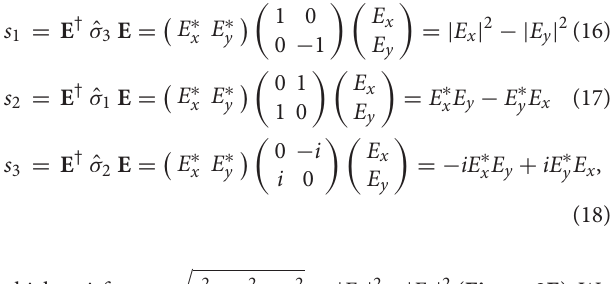
8. The input port 1 is used to inject photons to the waveguide, and the mode profile is obtained at z = E x ) and (B) the phase ( φ x ) of the horizontal electric field E x . (C) The amplitude ( | | iE x e − i φ , showing the direct tensor product state of the right-circularly-polarized state and the right-vortexed state, ∼ − ∝